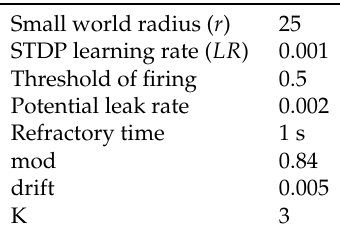
Table 1. NeuCube